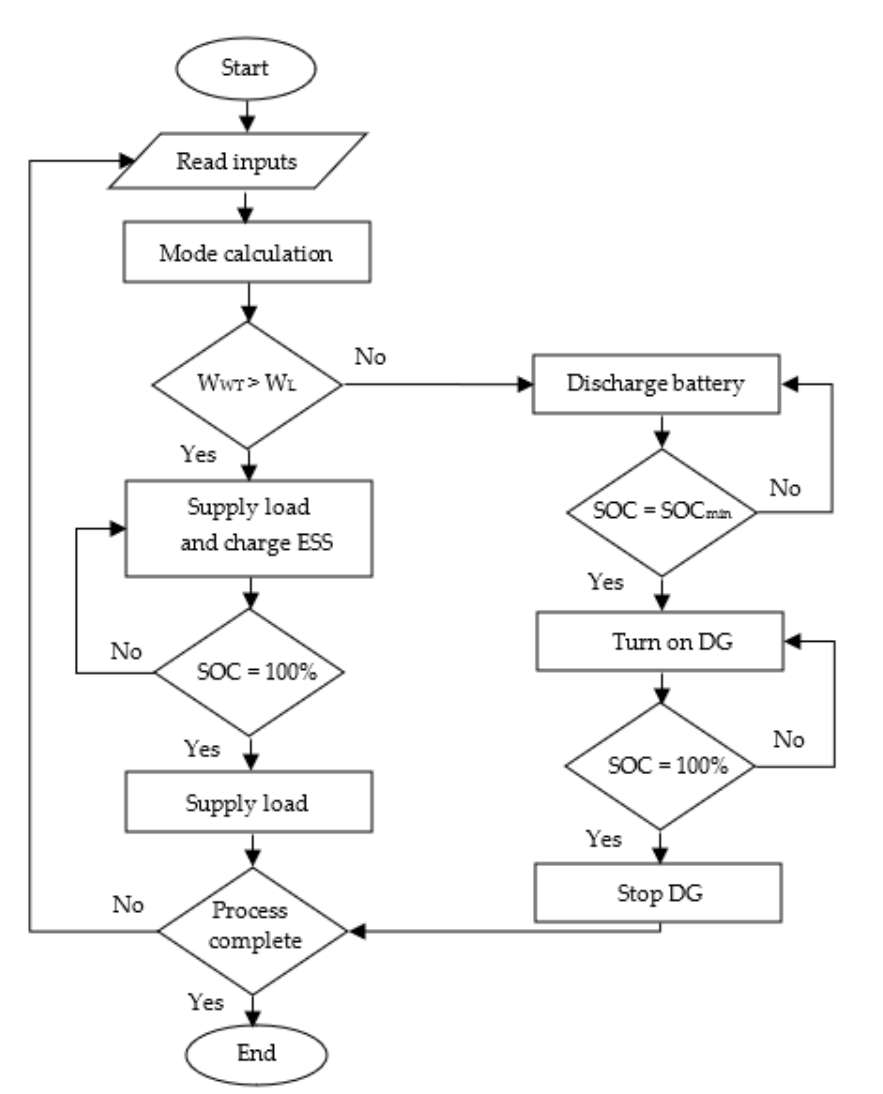
Figure 14. Flowchart of the WDHS with the high penetration operation algorithm: W WT —wind turbine energy generation; W L —load energy consumption; SOC—battery state of charge; SOC min —minimum allowable value of SOC. Adapted from Ref. [125].